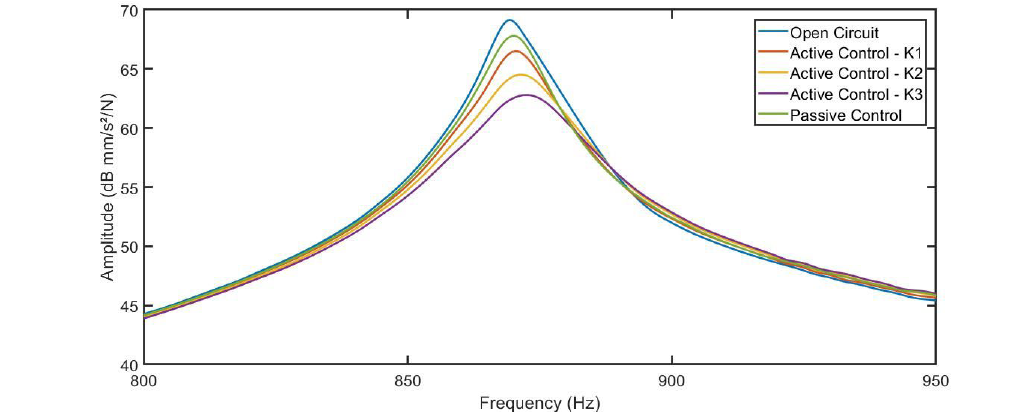
Figure 9. Experimental FRF amplitude with parallel multilayer piezoelectric actuator for first configuration.